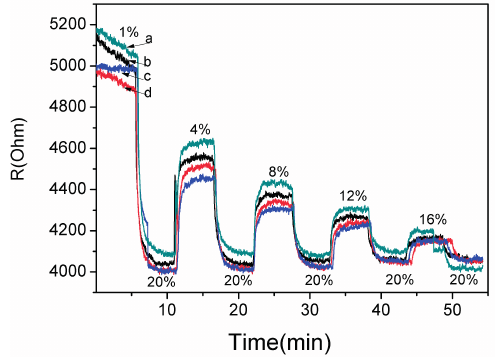
Figure 10. The response time of the gas microsensor at 240 °C with different oxygen partial